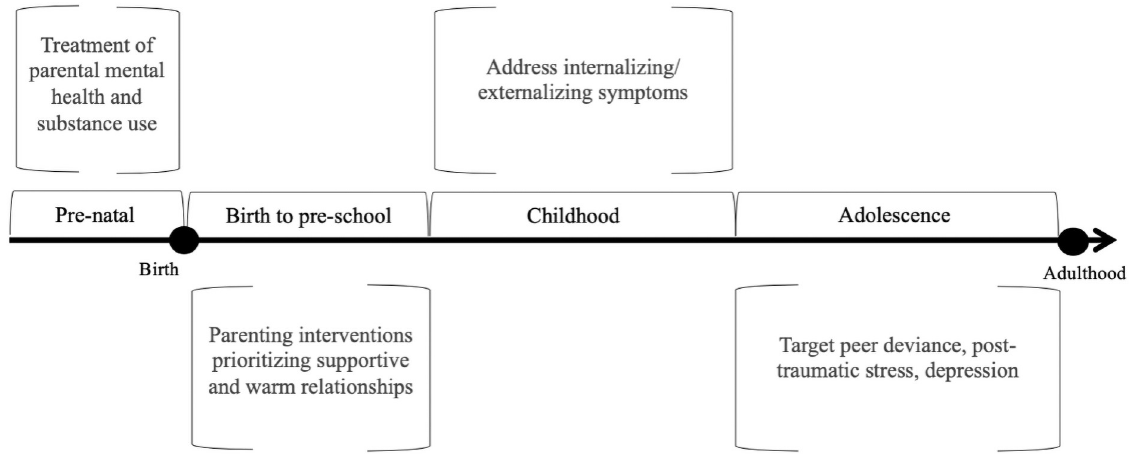
Fig 3. Timeline depicting different opportunities and targets for intervention. Possible timings and targets for intervention to prevent substance misuse in young people exposed to childhood adversity, based on synthesis of the existing literature.